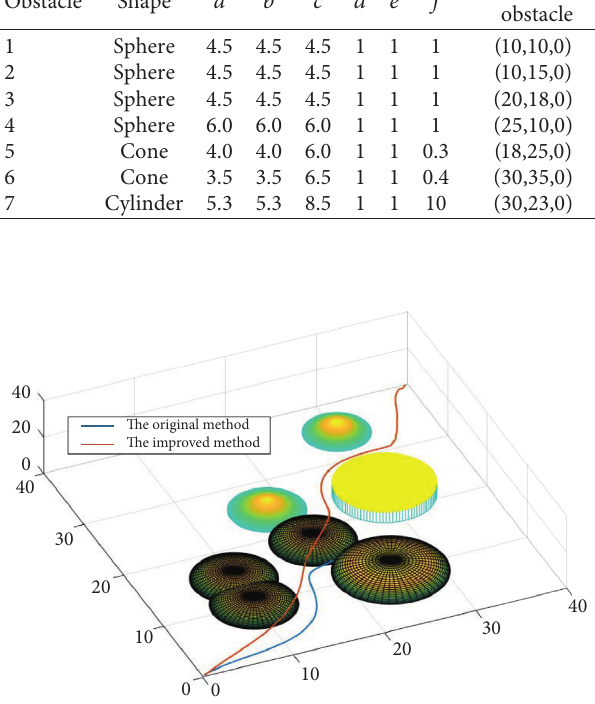
Figure 3: Unmanned aerial vehicle flying away from the trap area based on the improved algorithm.